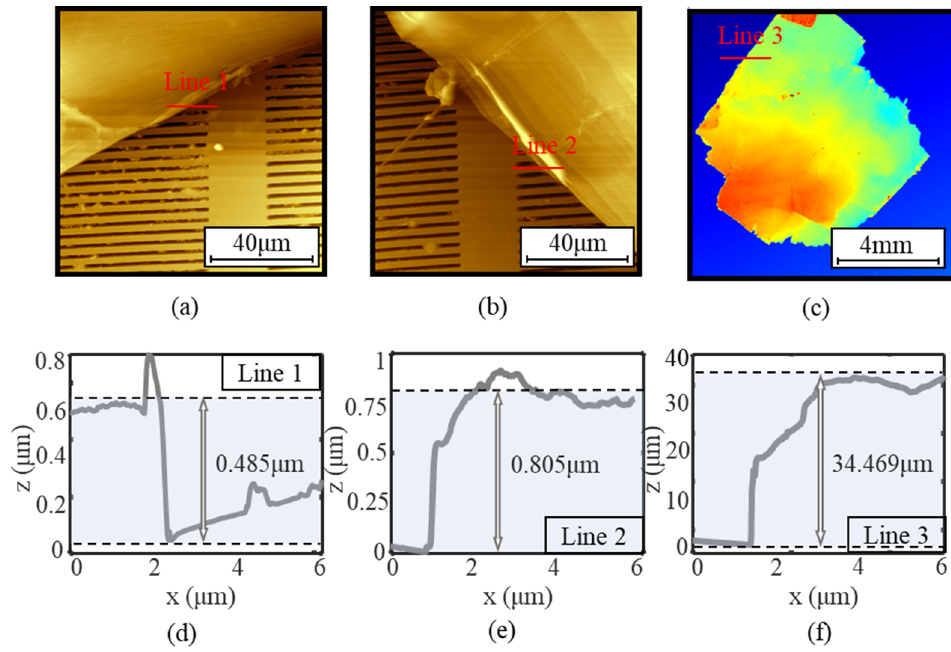
Figure 7. Characterization of the three samples prepared in the experiments. ( a , b ) show the AFM scan images at the edge of the HOPG films with two different film thicknesses covered on the Si substrates. ( c ) shows the white light interference image of the third sample with a different film thickness from the first two samples. ( d – f ) show the height difference of samples ( a – c ) on line 1, line 2, and line 3, respectively.